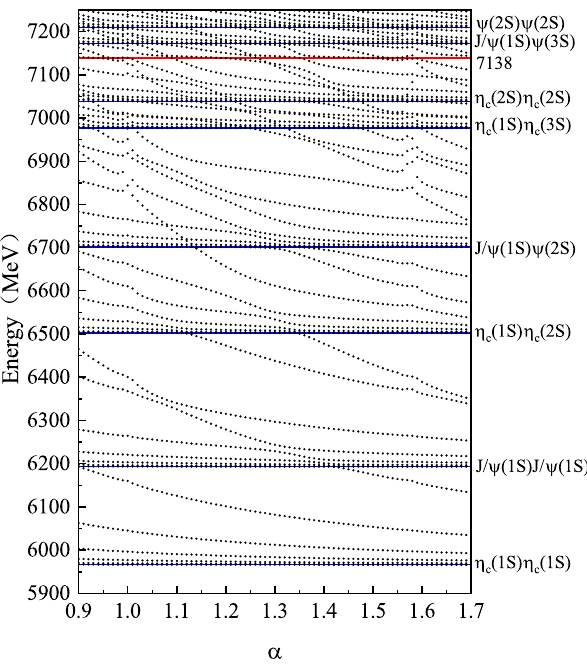
Figure 5. The stabilization plots for the energies of the states for J PC = 0 ++ obtained by considering the coupling between hidden-color channels ( η 8 c η 8 c ) 0 + ( J / ψ 8 J / ψ 8 ) 0 and the two scattering states ( η c η c ) 0 + ( J / ψ J / ψ ) 0 with respect to the scaling factor α . The red horizontal line represents the resonance states and the blue horizontal line represents the threshold, which is the same for the following